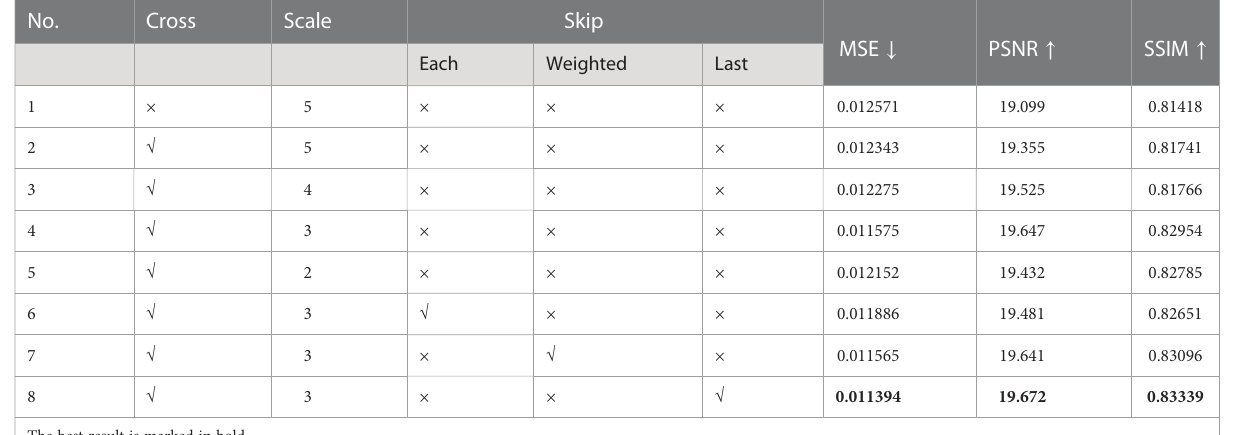
TABLE 3 Experimental results of adding multi-scale components. No.